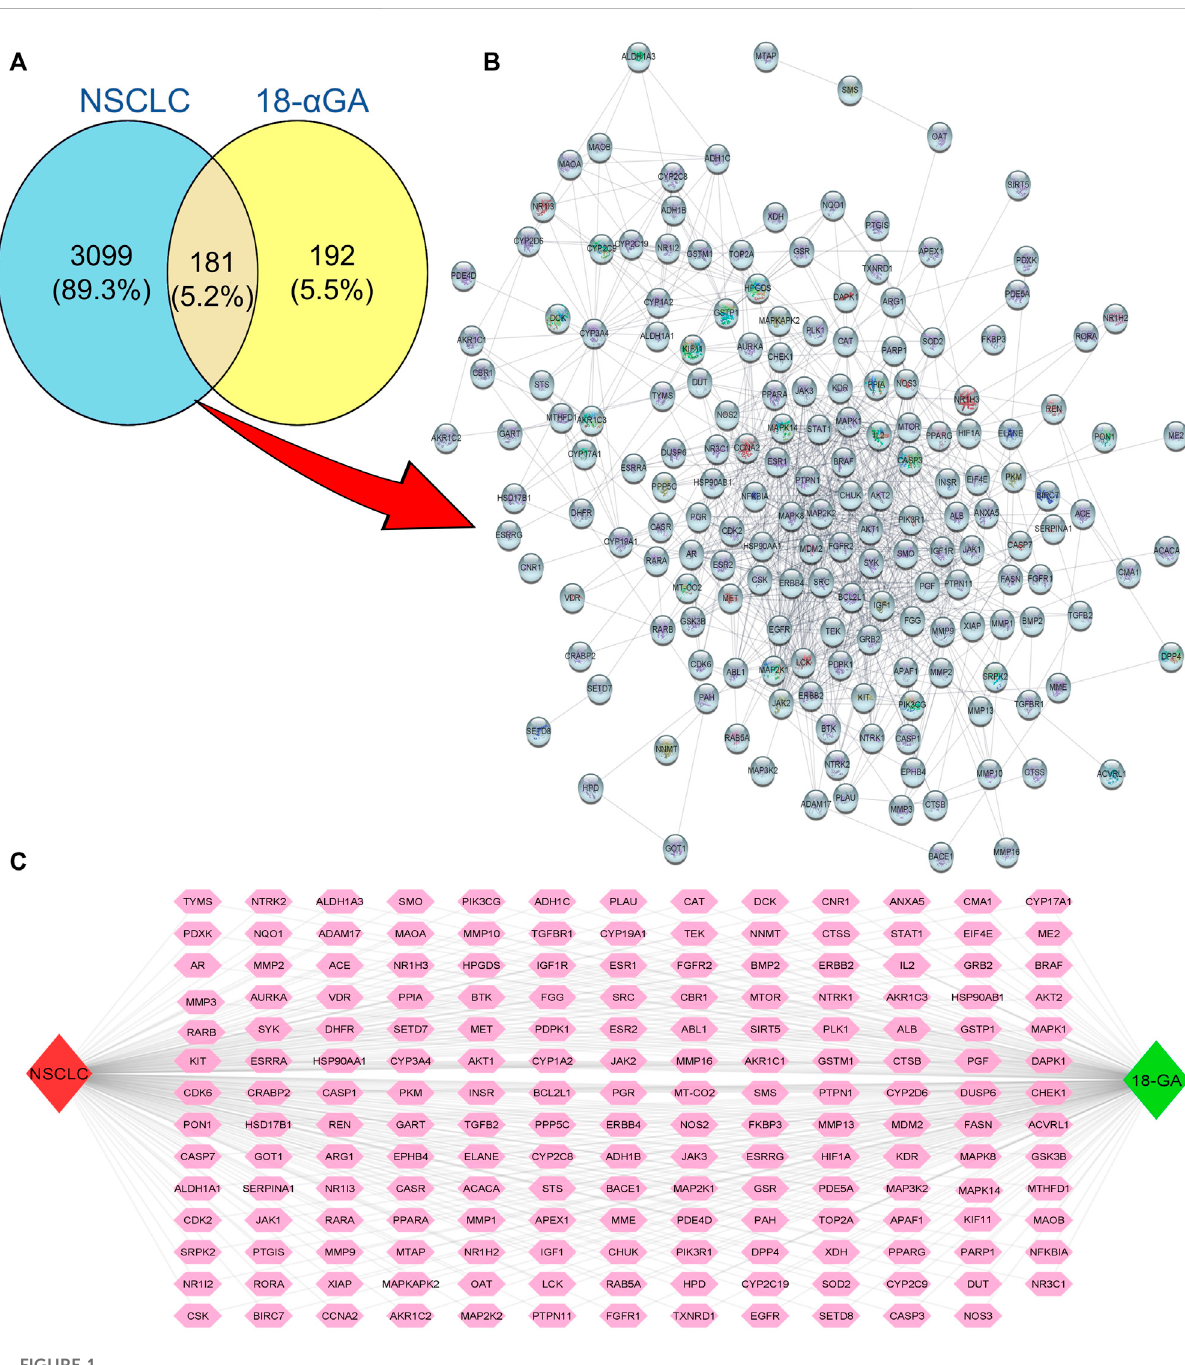
FIGURE 1 Putative targets of 18- α GA against NSCLC. (A) Venn Diagram showing 181 overlapping targets between 18- α GA and NSCLC by Venny 2.1.0. (B) Protein-proteininteraction(PPI)networkof181nodesand964edgesof18- α GAandNSCLCasvisualisedby Cytoscapev3.9.0 . (C) The “ Compound- Target-Disease ” Network constructed by Cytoscape v.3.8.2, the Green diamond represents the compound name, the Red diamond represents the disease name, and Pink hexagons show common targets between 18- α GA and